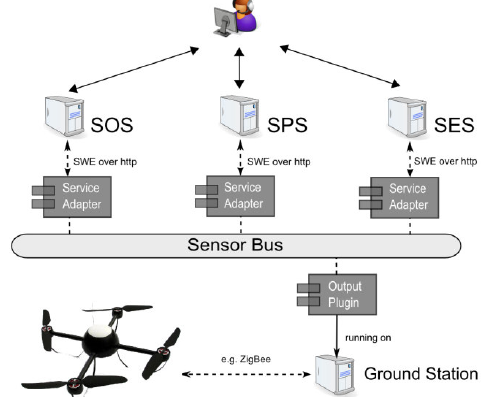
TABLE 3. 2007 WESTERN STATES FIRE MISSION SUMMARY Flight date